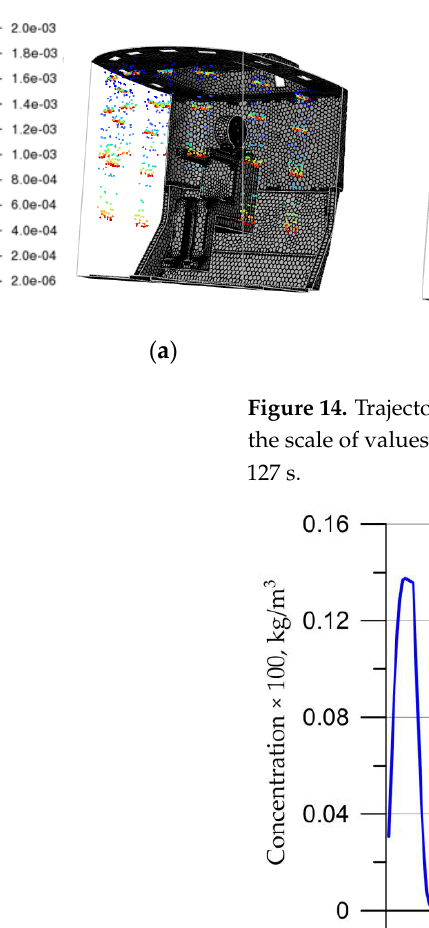
( b ) Figure 13. Trajectories and particle diameters of pathogens during the driver ’ s cough, the colors on the value scale correspond to the particle diameter size ( a ) with volatility and ( b ) without volatility. 4. Discussion From the results of the particle trajectories in Figures 12 and 13, the following pat- terns can be noted: ➢